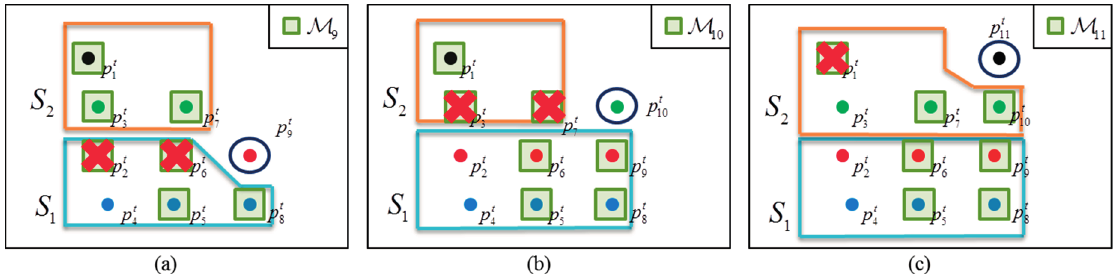
Figure 9. Robust segmentation for multi-layer laser